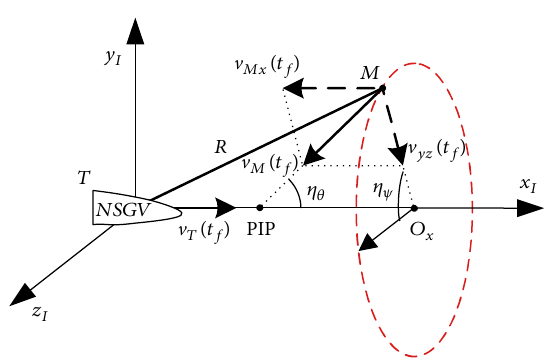
Figure 1: Geometric relationship to be satis fi ed in the collision between an interceptor and a